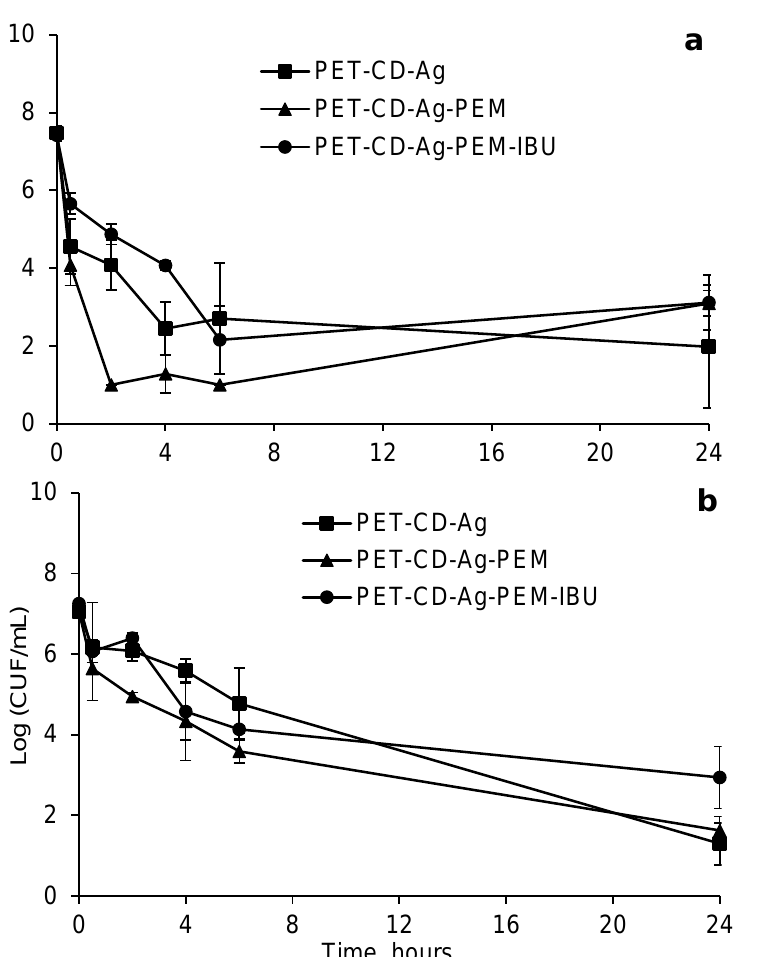
Figure 10. Kinetics bacterial reduction of S. aureus ( a ) and E. coli ( b ) in contact with different dressings at different times (0.5 to 24 h). Initial bacterial load: 7 Log 10 CUF/mL.